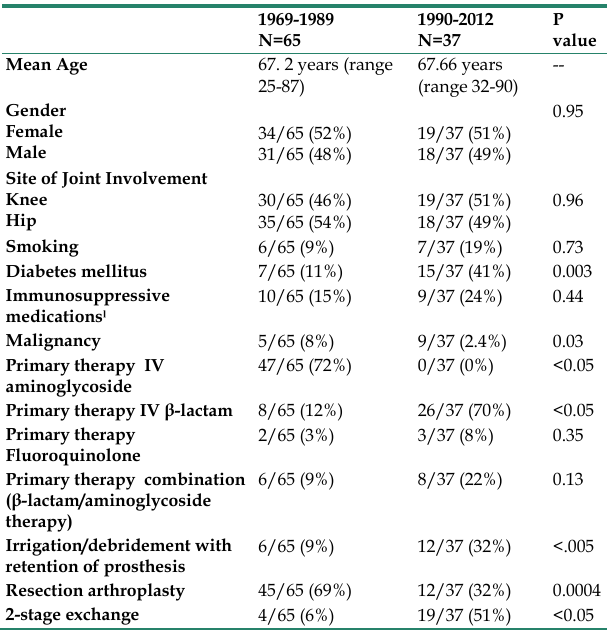
Table 3 . Characteristics of episodes of Pseudomonas PJIs based on time